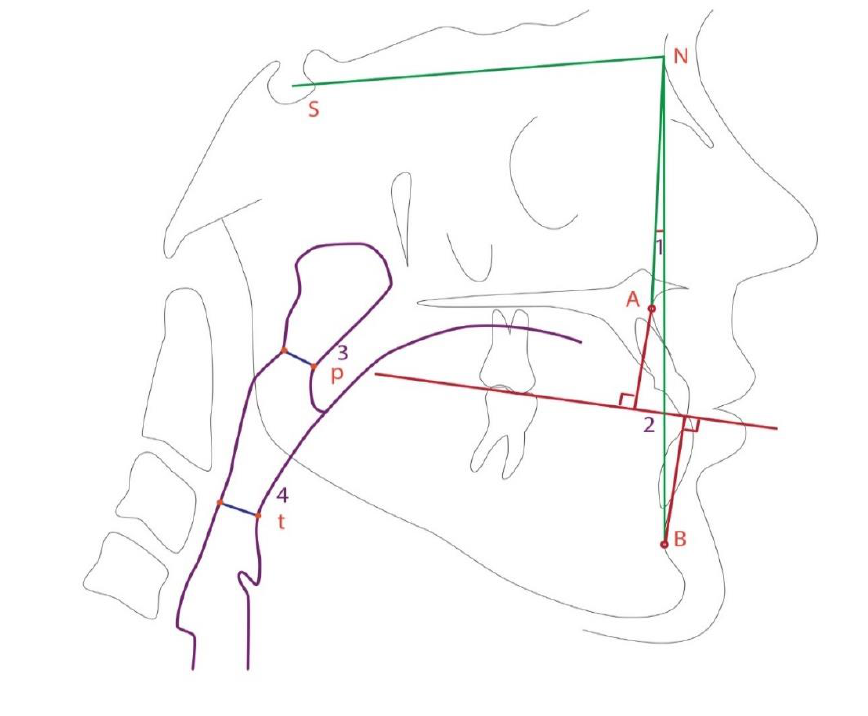
Figure 1. Measurements on lateral cephalograms: 1) ANB angle, 2) Witt’s appraisal, 3 and 4) upper pharyngeal airway